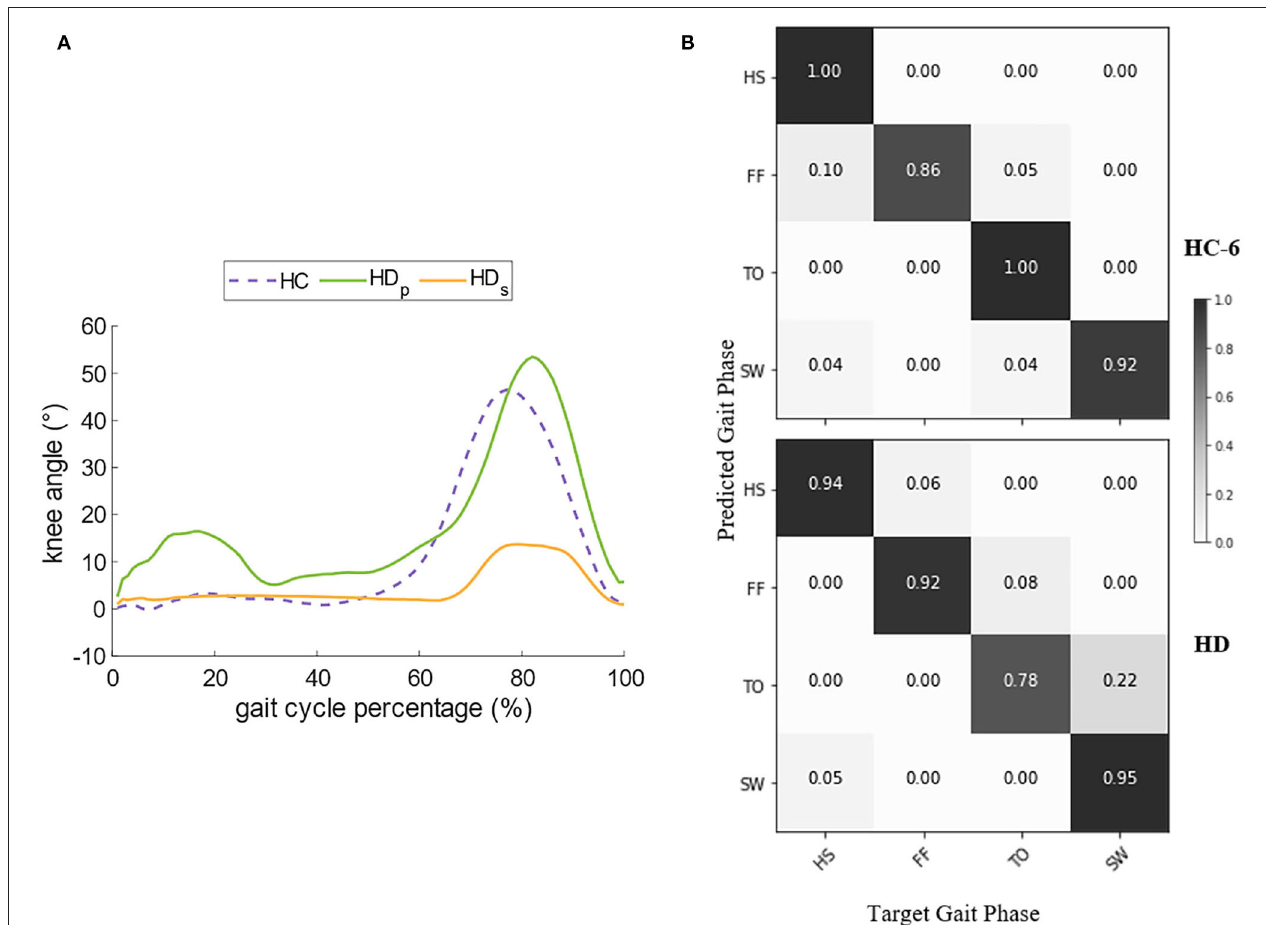
FIGURE 7 | Comparison of the knee angle and the decoder’s performance between HC (Healthy Controls) and HD (Hip Disarticulation) groups. (A) Compares the dominant knee angle of HC and the bilateral knee angle of HD, and (B) compares the decoder’s performance in the confusion